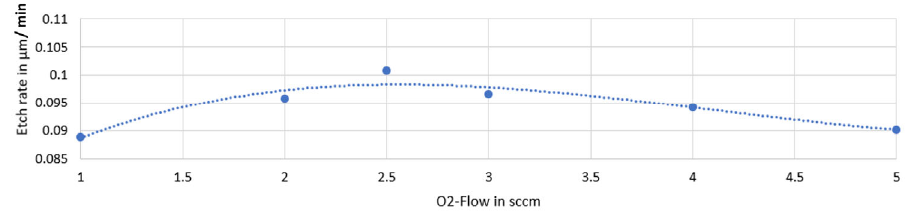
Figure 3. Relation between the O 2 flow and etch rate.